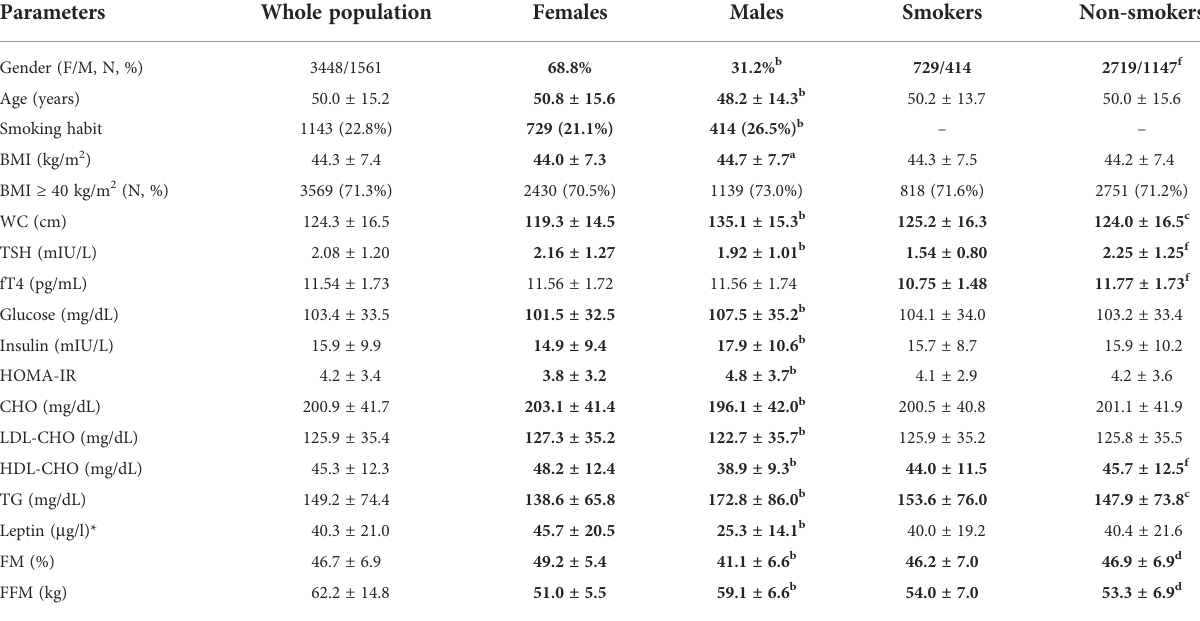
TABLE 1 Summary of anthropometric and metabolic variables in the population as a whole and subgrouped according to gender and smoking habit.